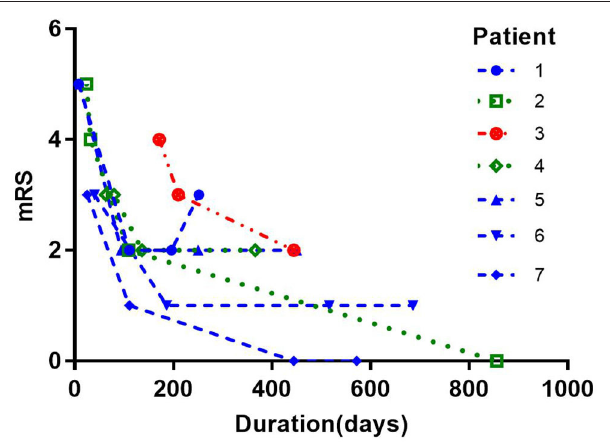
FIGURE 2 | Modified Rankin score (mRS) in patients in part two of the study. Green: only first-line treatment (IVIG/corticosteroids). The median mRS was 2.5 (0–5). Blue: first-line treatment plus mycophenolate mofetil. The median mRS was 2 (0–5). Red: first-line treatment plus rituximab. The median mRS